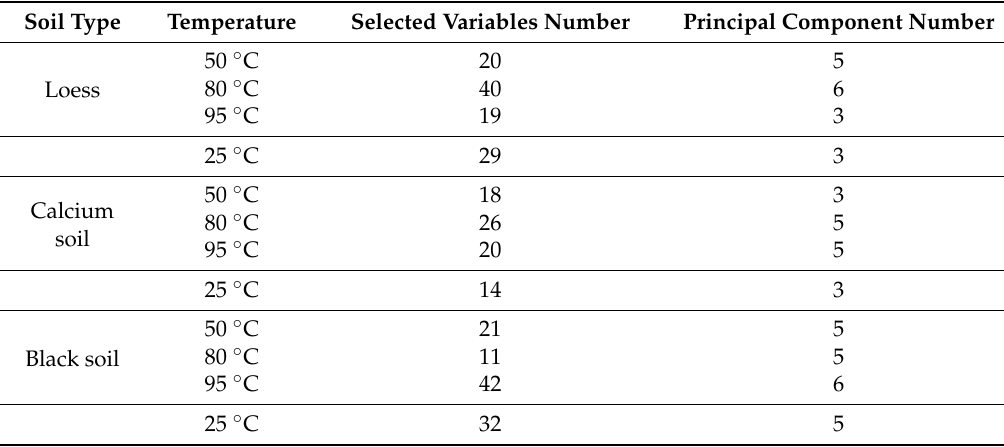
Table 4. The selected variables and principal component number.